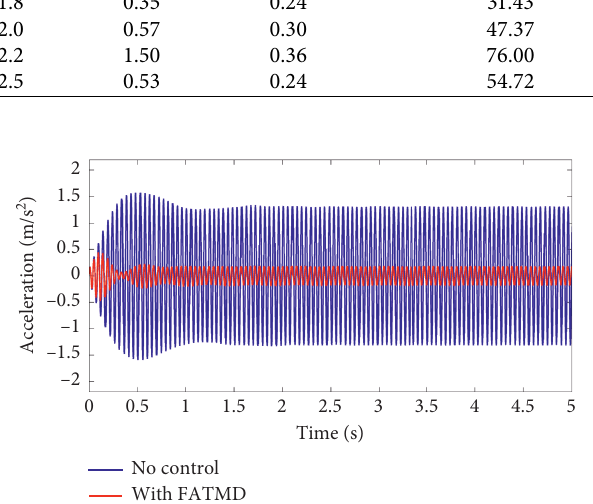
Figure 15: The acceleration time history in the midspan of the